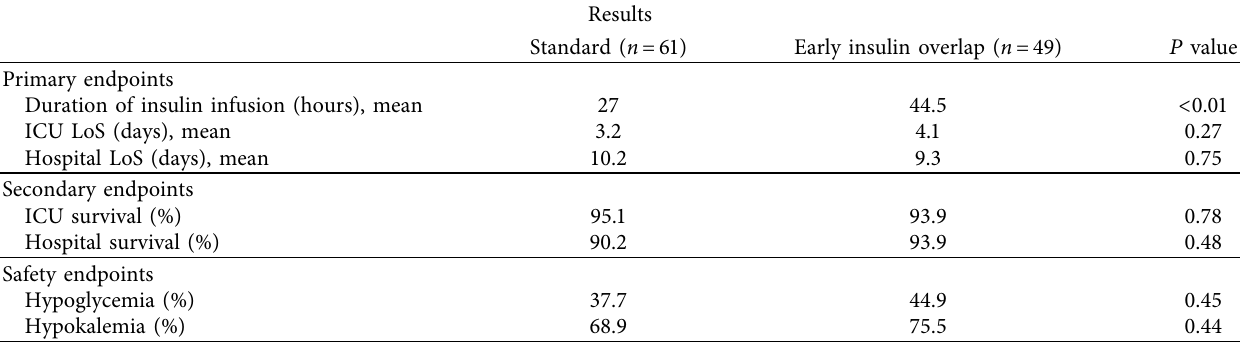
Table 4: Standard overlap vs. early addition of long-acting insulin to